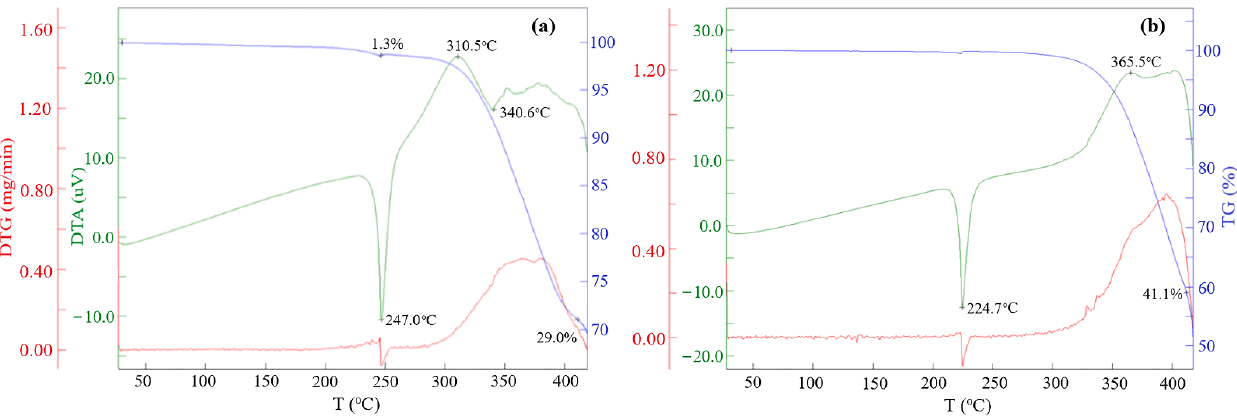
Figure 2. TG, DTG, DTA, and temperature curves as a function of time for derivatives 2a ( a ) and 3a ( b ), heating rate 10 °C min − 1 , air.